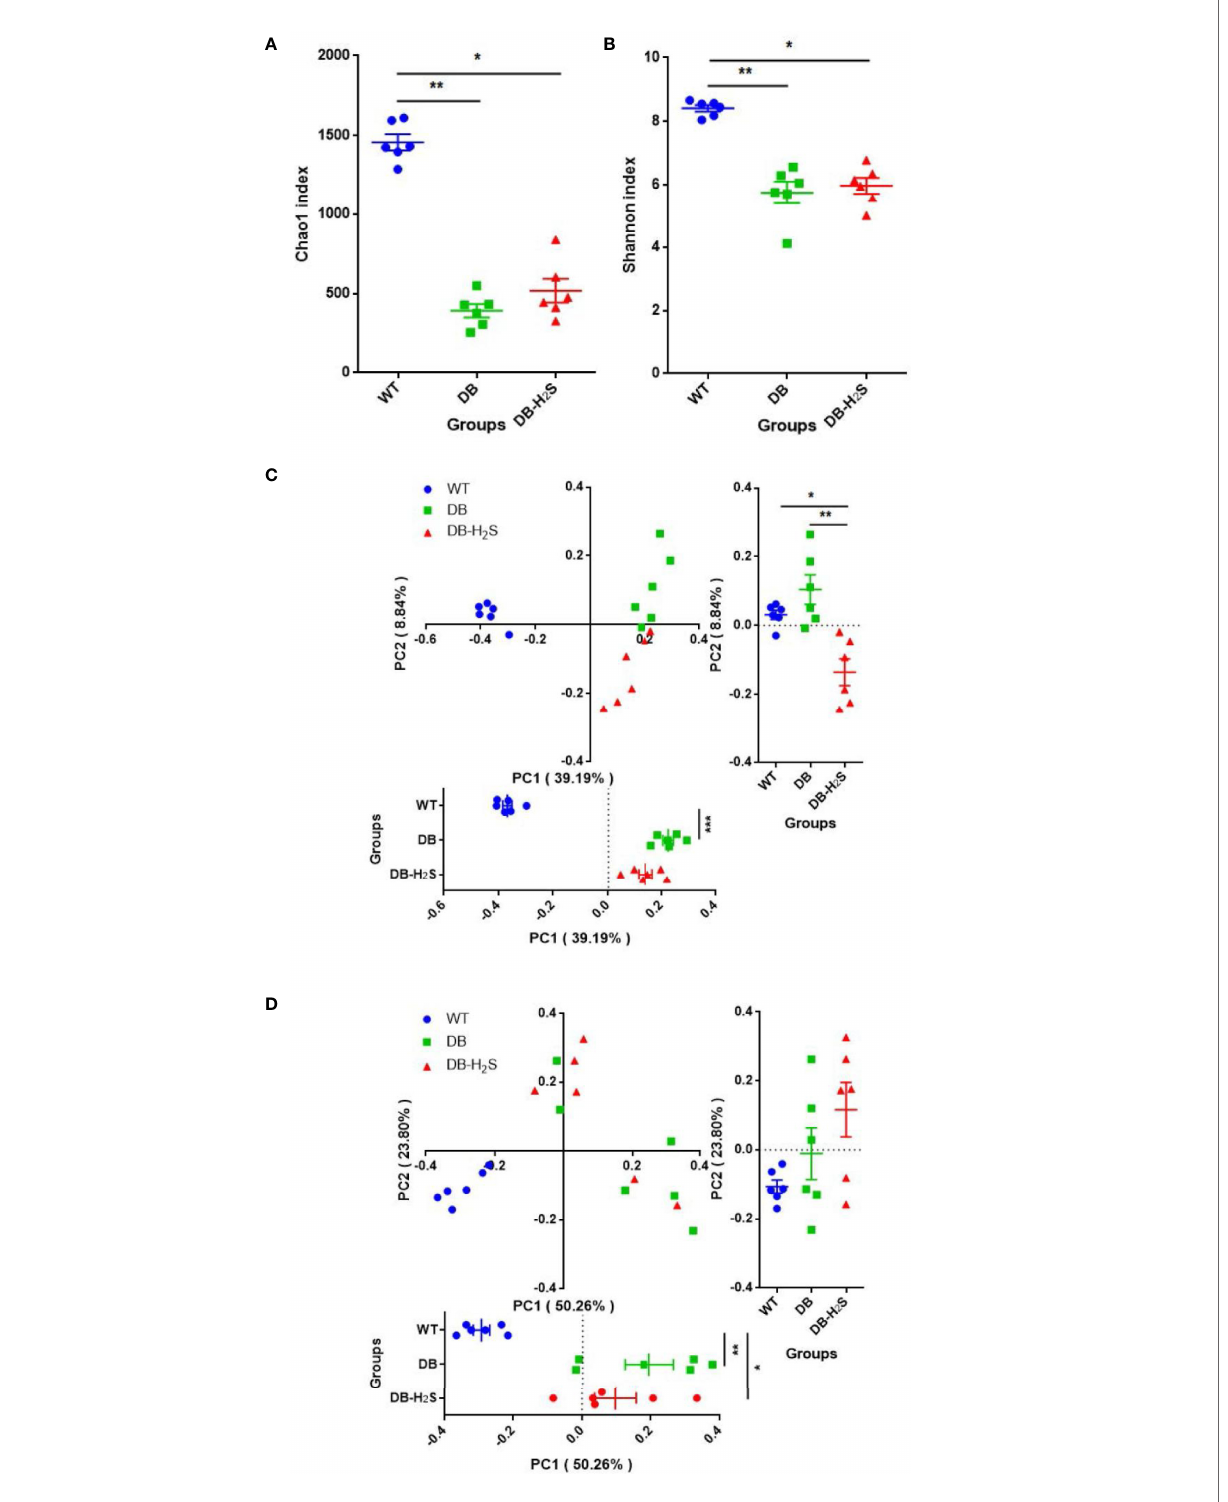
FIGURE 3 | Effect of exogenous H 2 S on the gut microbiota structure. (A) Chao1 index. (B) Shannon index. (C) Unweighted UniFrac distance-based principal coordinate analysis (PCoA). (D) Weighted UniFrac distance-based PCoA. WT, wild-type mouse group (n = 6); DB, db/db mouse group (n = 6); DB-H 2 S, db/db mouse treated with NaHS group (n = 6). Data are shown as mean ± SEM. Differences were analyzed by the Kruskal – Wallis test with Dunn ’ s multiple-comparison test and denoted as follows: * p < 0.05, ** p < 0.01, *** p <